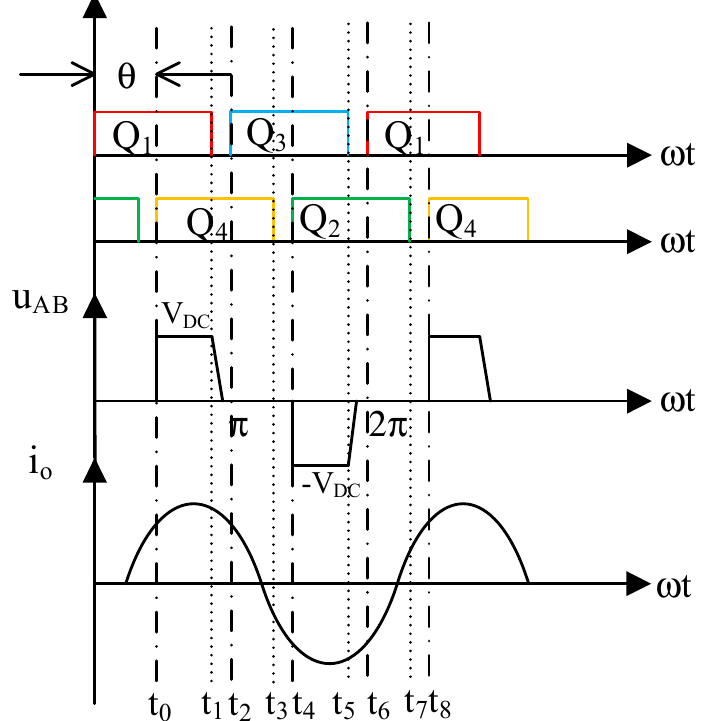
Figure 2. Phase-shift control signal and load voltage and current waveforms.